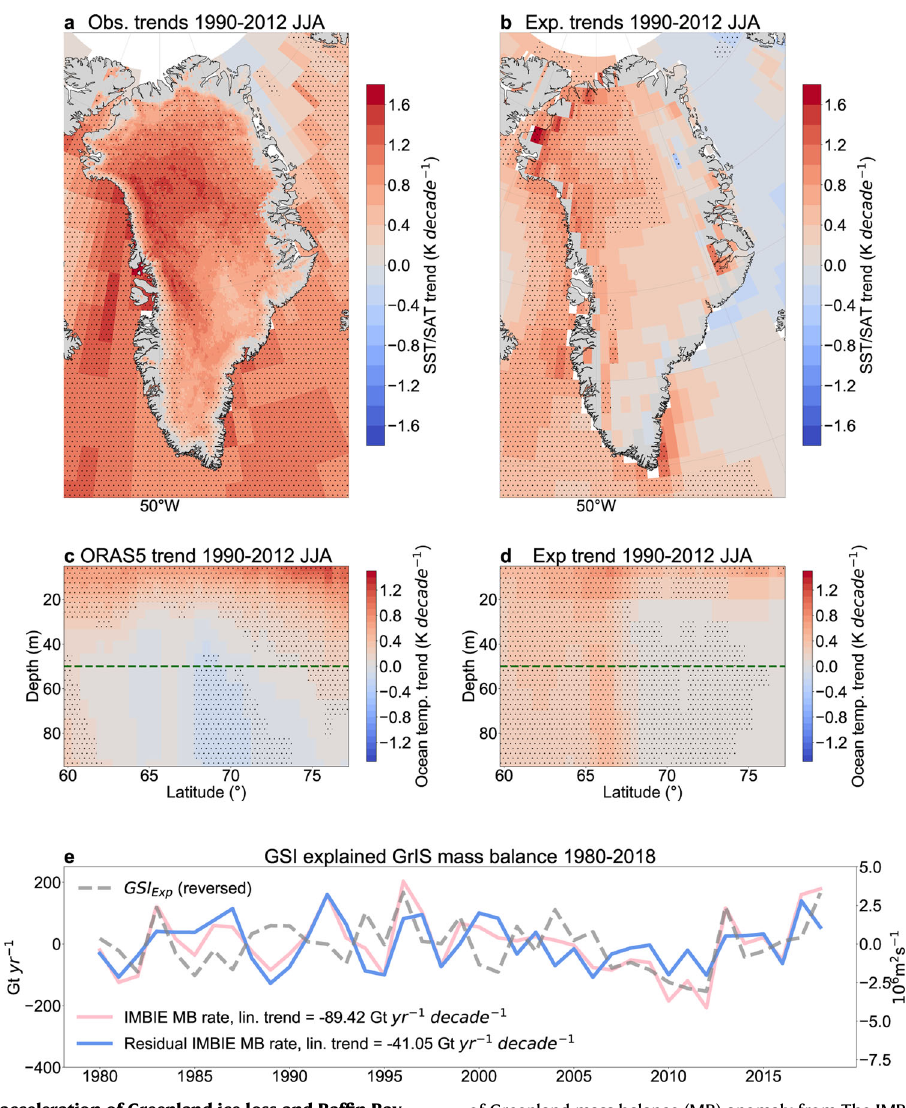
of Greenland mass balance (MB) anomaly from The IMBIE Team 6 (pink) and the linearlydetrended summer500hPaGreenlandstreamfunctionindexderived from the nudging experiment (GSI Exp, grey).The residualrate of Greenland MB anomaly (blue) based on having linearly regressed out the GSI Exp (grey) from the annual meanrateofGreenlandmassbalanceanomaly(pink)isalsoshown.Thelineartrend values in the legend refer to the 1990 – 2012 period. Note that these values differ from those mentioned in the main text, because these are obtained after having removed the 1980 – 2018 linear trend from the mass balance time series as a fi rst order approximation of anthropogenic